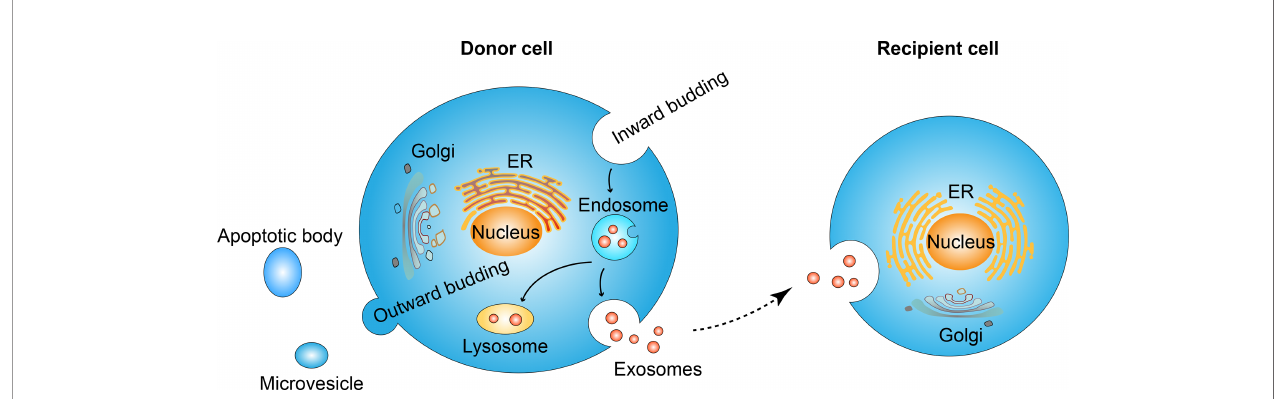
FIGURE 1 | Exosome formation and uptaking process. Inward budding of cell membrane leads to the formation of the endosome. Further inward budding which encapsulates cell components leads to the formation of vesicles inside the endosome. The membrane of endosome fuse either with lysosome and result in the degradation of endosome contents, or fuse with cell membrane and lead to the release of its vesicles, namely exosomes. Secreted exosomes will be uptaken by recipient cells and the internalized contents are thus transferred in an autocrine, paracrine, or endocrine manner. In contrast to the inward budding process, the out ward budding of the membrane leads to the formation of microvesicles or apoptotic